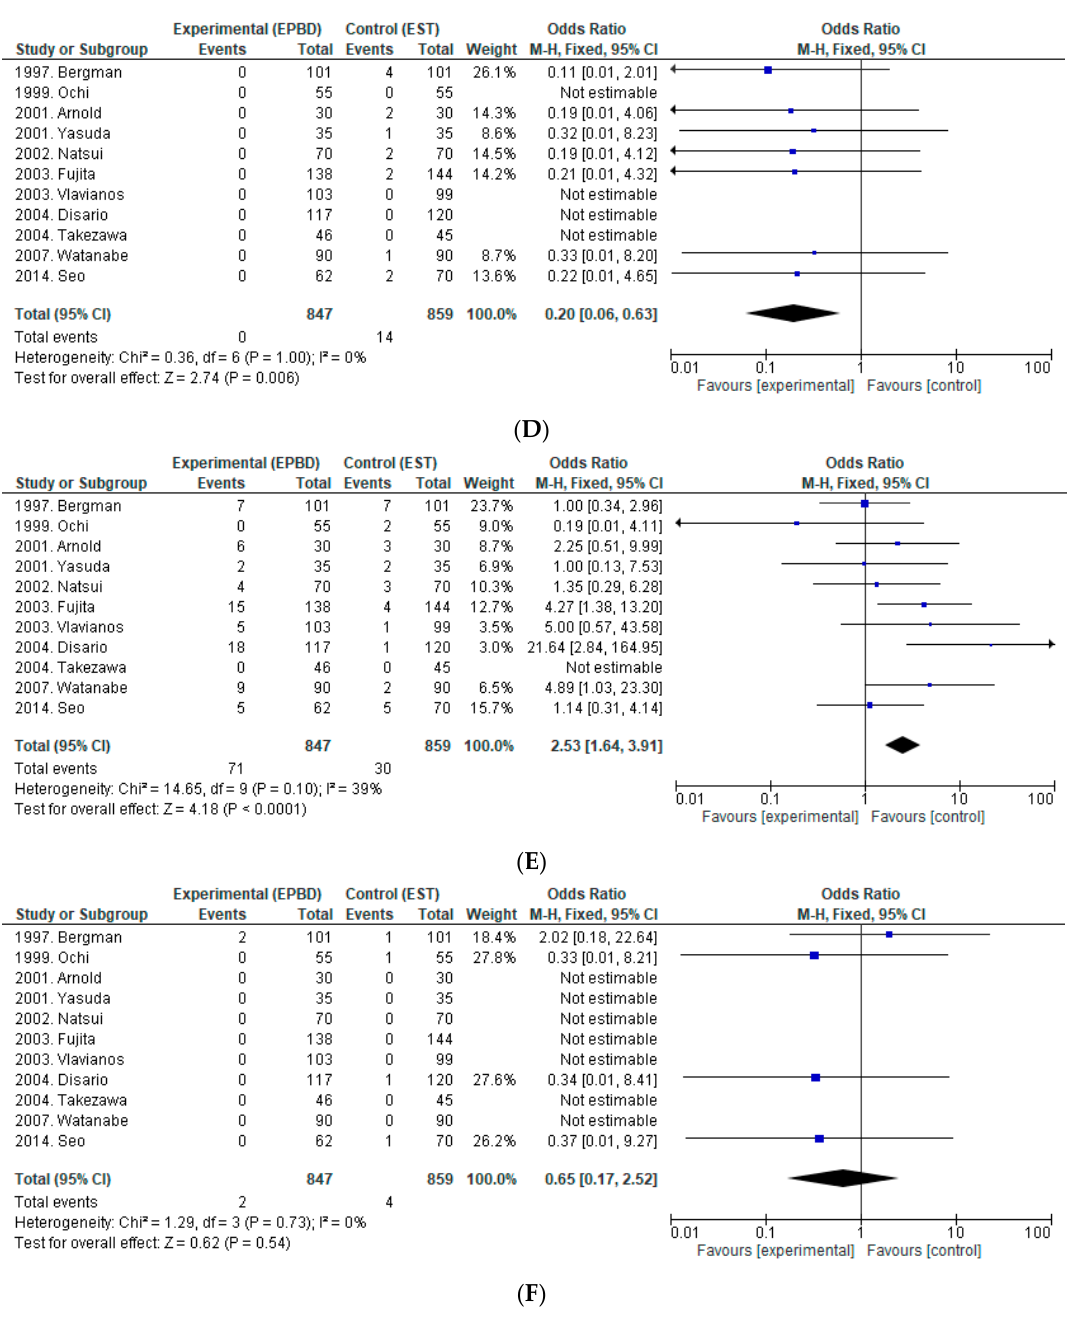
Figure 1. Forest plot of risk ratios and 95%CIs representing a comparison between EST and EPBD. ( A ): Complete stone removal at the first endoscopic session ( B ): Rate of mechanical lithotripsy. ( C ): Overall adverse events. ( D ): Bleeding. ( E ): PEP. ( F ): Perforation. CI, Confidence interval; EST, endoscopic sphincterotomy; EPBD, endoscopic papillary balloon dilation; PEP, post-endoscopic retrograde cholangiopancreatography pancreatitis.